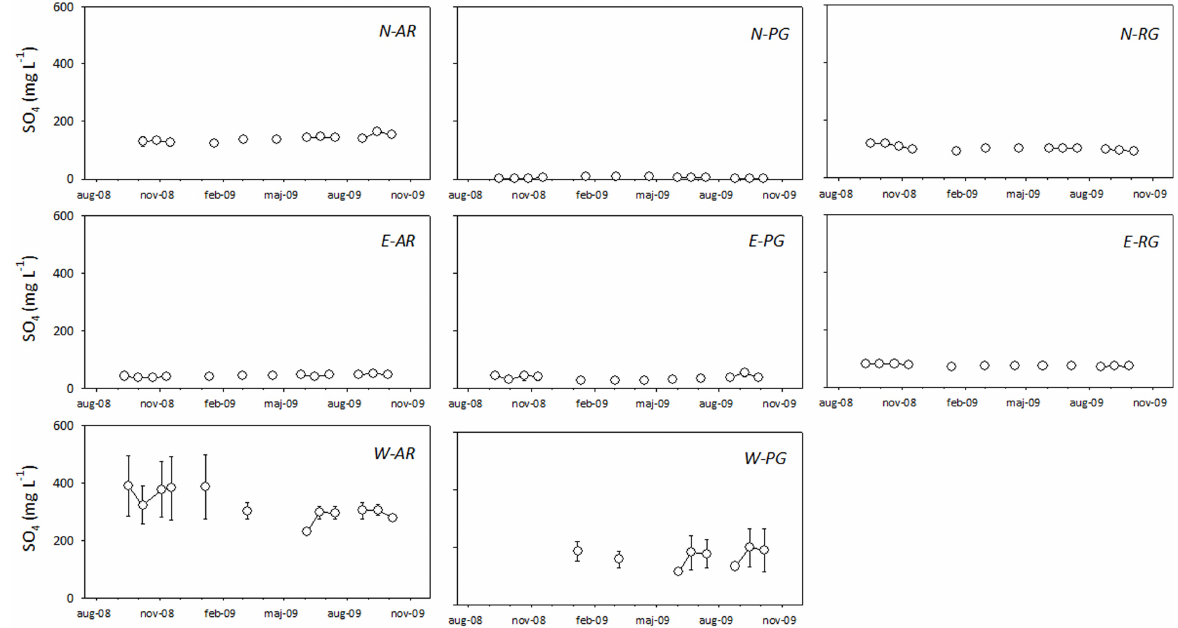
Fig. 4. Seasonal variations in groundwater sulfate (GW-SO 2 − ) at the eight monitoring sites; for information about site ID, see legend to 4 Fig. 2. Fresh groundwater was sampled from piezometers at the paired sampling points during gas flux measurement campaigns (the data shown represent mean ± standard error, n = 3). The data set was incomplete due to resource